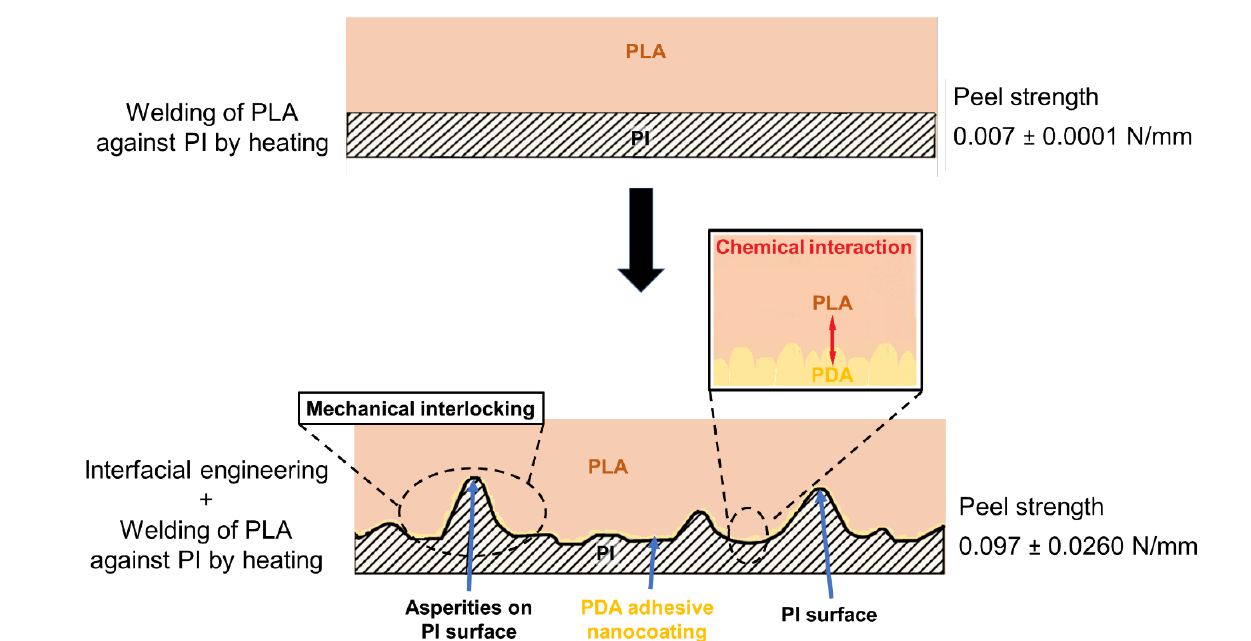
Figure 7. Schematic of the expected adhesion mechanisms between PI and PLA in the case of the treatment providing the highest adhesion force, which was PI surface abrasion followed by PDA coating.